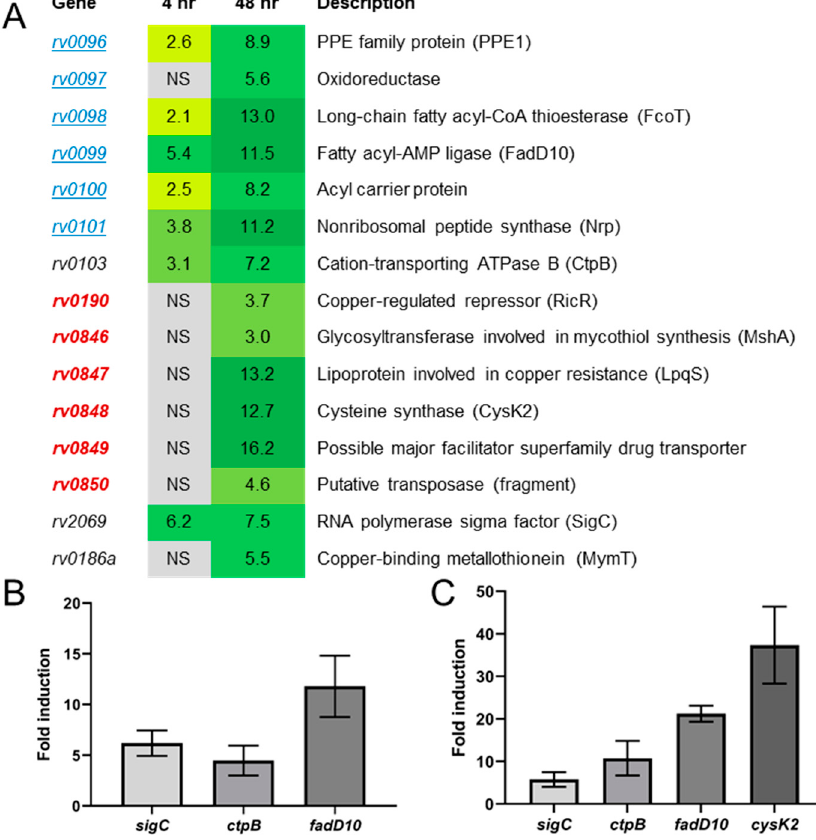
Figure 2. ( A – C ). Genes expressed >2-fold after 4- or 48-h sigC induction in Erdman in 7H9 medium. ( A ) Global gene expression studies using DNA microarrays in strain Erdman carrying a plas-